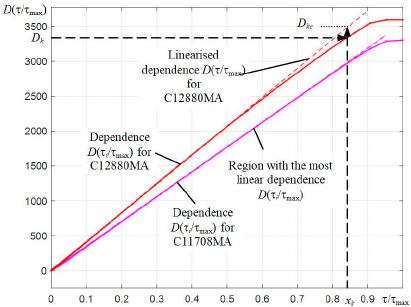
Figure 3. Measured light characteristics of C12880MA and C1170MA microspectrometers, normalized along the abscissa axis, and an illustration of the process of their linearization. Analyzing the graphs in Figure 3, we see that the measurement mode with a Global Shutter used in the photodiode line of the C12880MA spectrometer has the worst linearity